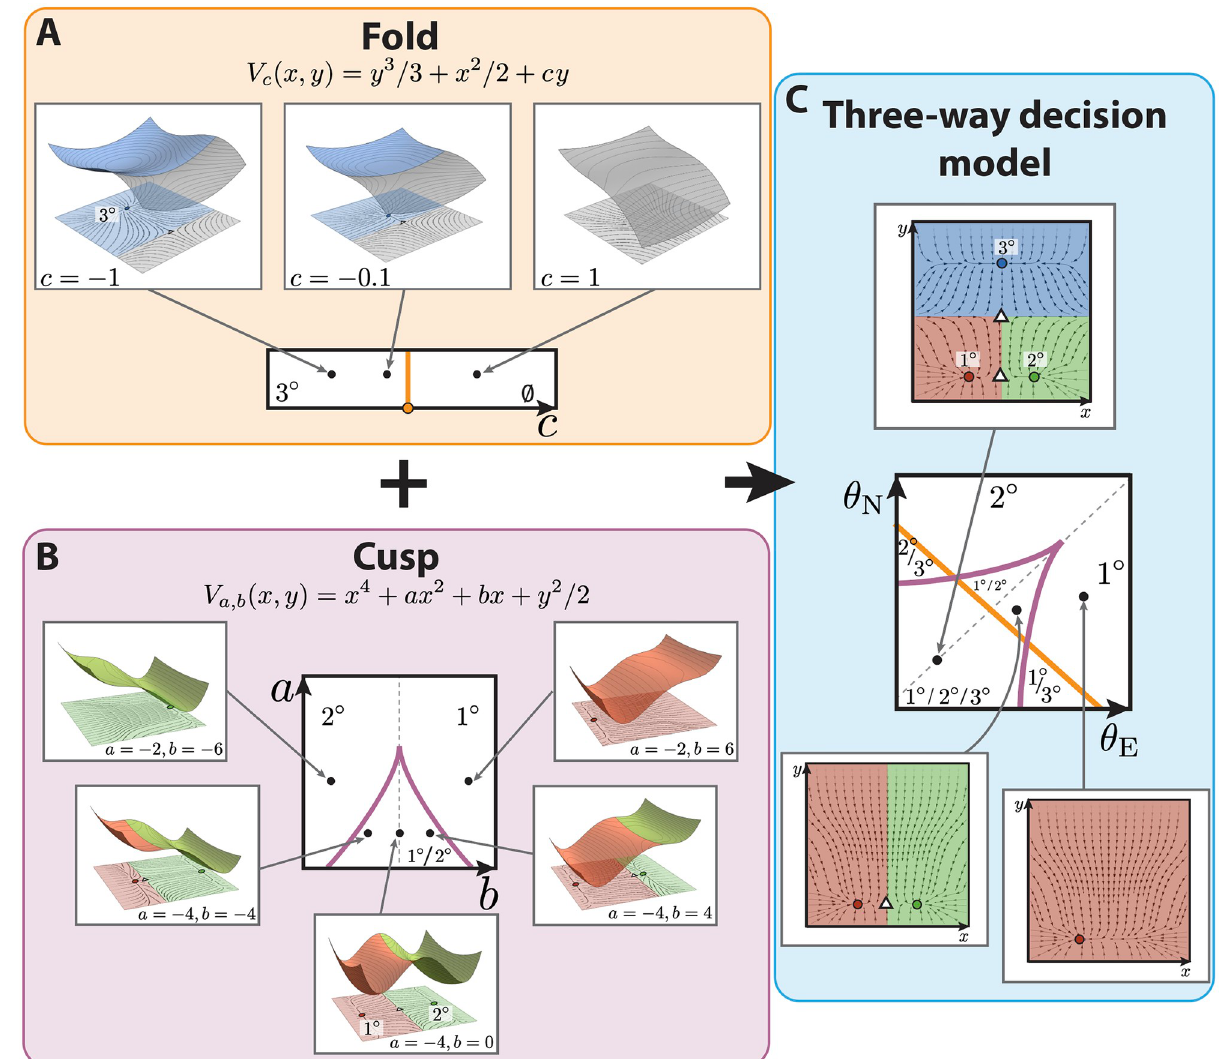
Fig 2. Binary flip with cusp model of vulval development in C. elegans . (A) The fold catastrophe, controlled by the parameter c , defines the stability of the attractor representing 3˚ fate. The fate map is represented at the bottom, showing that the fold has a bifurcation at c = 0 (in orange), separating two stability regions: one containing 3˚ fate (for c < 0) and one where the fate disappears ( c > 0). At the top, from left to right, different examples of landscapes for different values of c . For c < 0, the potential has two critical points in the state space: a minimum (blue circle) and a maximum (white triangle), such as the one represented on the top panels. Close to the bifurcation point, c = 0, the two critical points get near each other to merge together. For values of c > 0, the potential does not contain any critical point. (B) The cusp catastrophe, controlled by the parameters a , b , defines the stability of the attractors representing 1˚ and 2˚ fates. The fate map, at the center, shows that the cusp has a bifurcation set determined by Δ = 8 a 3 + 27 b 2 = 0 (purple cusp), separating three stability regions: one containing 1˚ and 2˚ fate (for Δ < 0) and two where only one of the two fates is present ( Δ > 0). Examples of landscapes determined by different values of a , b are shown; in each case, 1˚ and 2˚ are represented by red and green circles, respectively, and the saddle between them is represented by a white triangle. On the cusp mid-line (gray dotted line in the fate map) the two fates are equally probable. Getting closer to the cusp favors one fate over the other, by the saddle approaching one of the attractors. Outside the cusp, the landscape only has one attractor, either 1˚ or 2˚. (C) The two catastrophes are combined to generate a 2-dimensional flow with two saddles (white triangles) and three attractors representing each fate (blue, green and red circles represent 3˚, 2˚ and 1˚ fates, respectively). By mapping the signals θ E , θ N onto the control parameters a , b , c , a fate map is obtained, defining the available fates in the landscape for different signaling profiles. The presence of 3˚ fate is controlled by the fold line, as shown in (A), and the stability of the 1˚ and 2˚ fates is controlled by the position of the signaling profile with respect to the cusp line, as shown in (B).